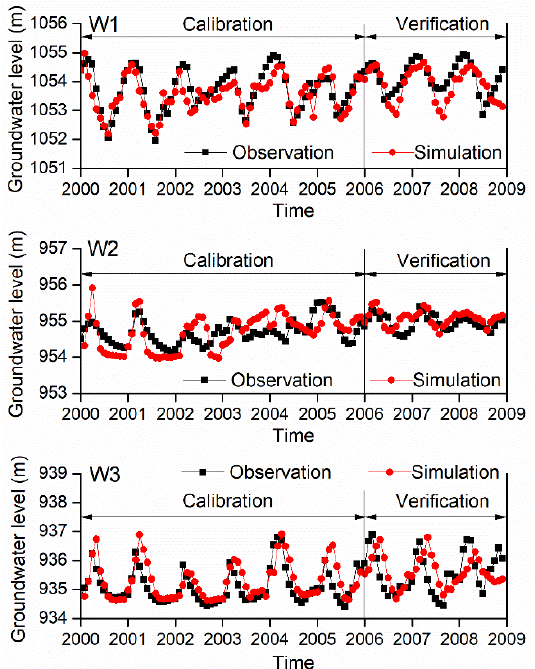
Figure 8. Comparisons between simulated and measured groundwater levels of three wells in the lower reach.